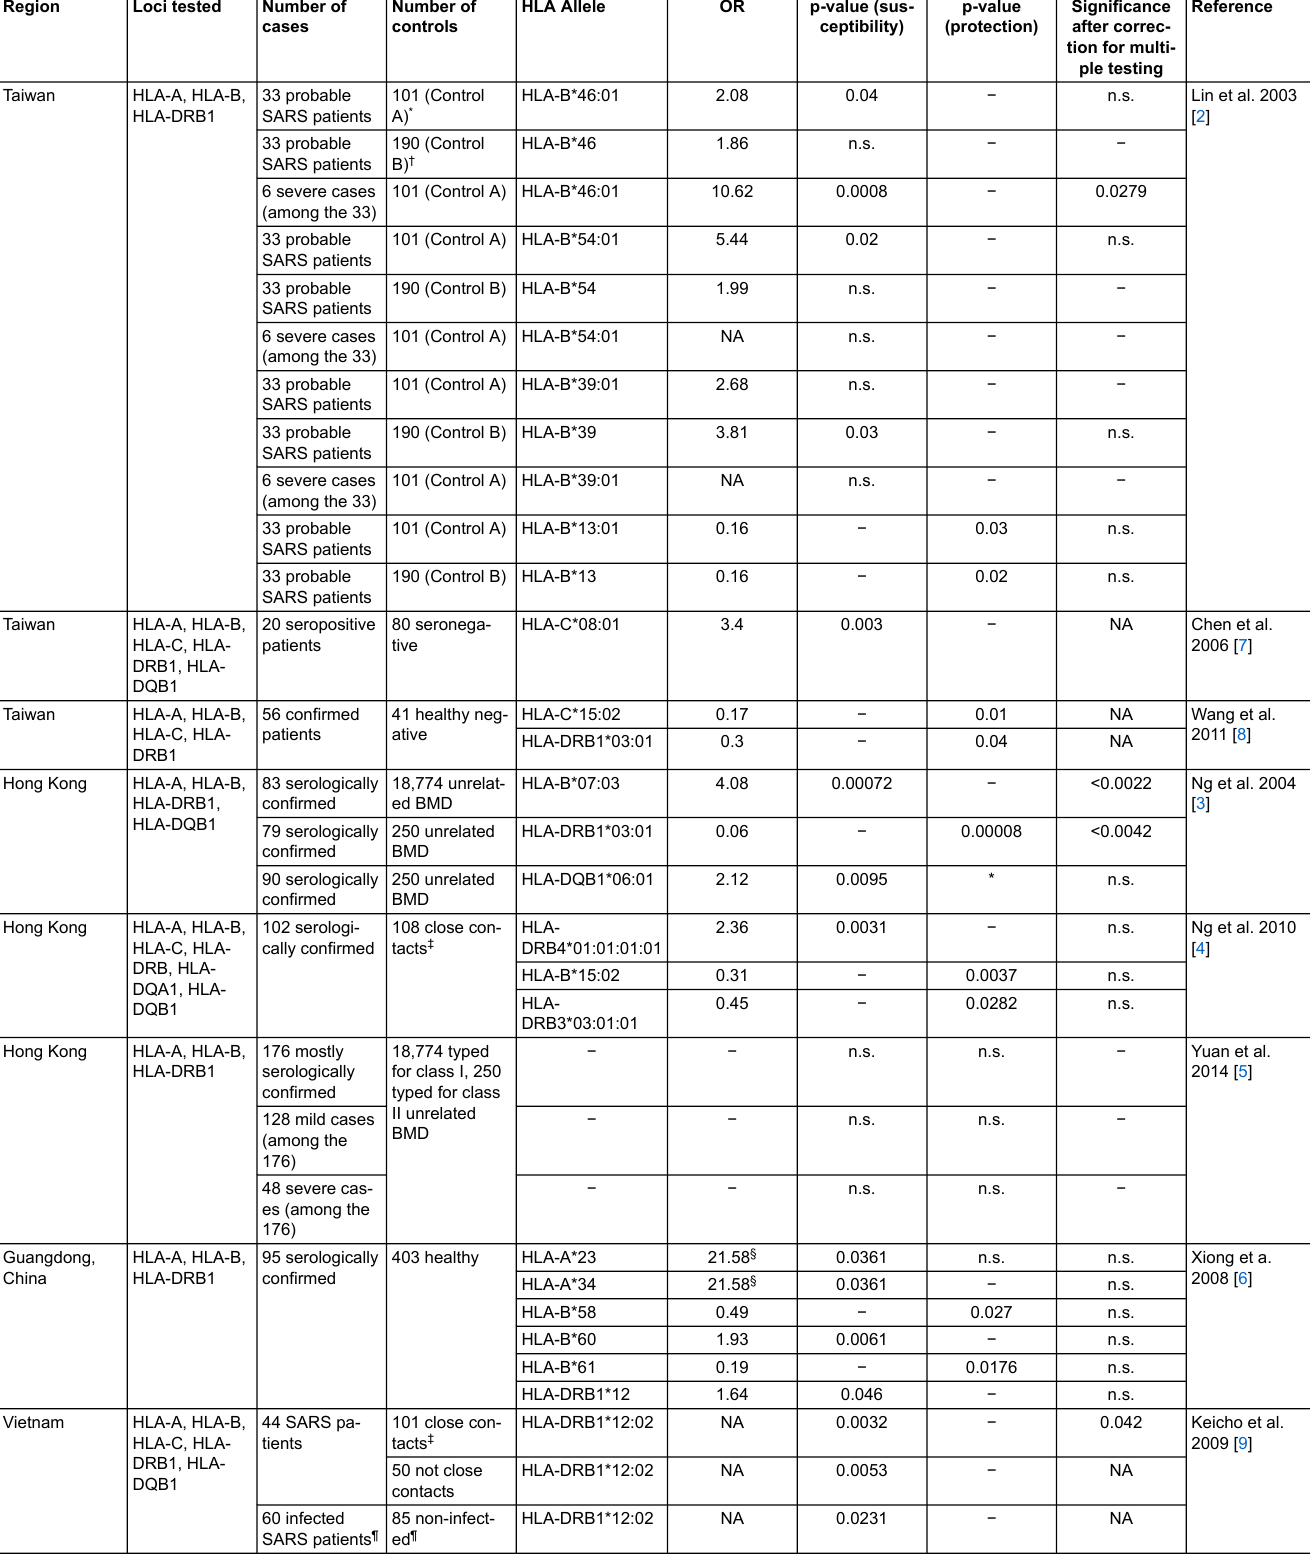
p-value Significance Reference ceptibility) (protection) after correc- tion for multi- ple testing